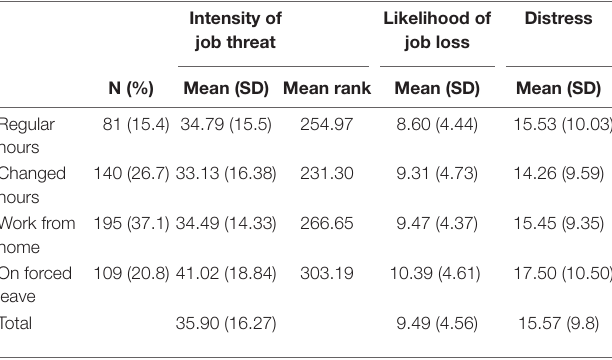
TABLE 2 | Differences between groups of different working conditions during pandemic on intensity of threat, Likelihood of job loss and Distress scales.